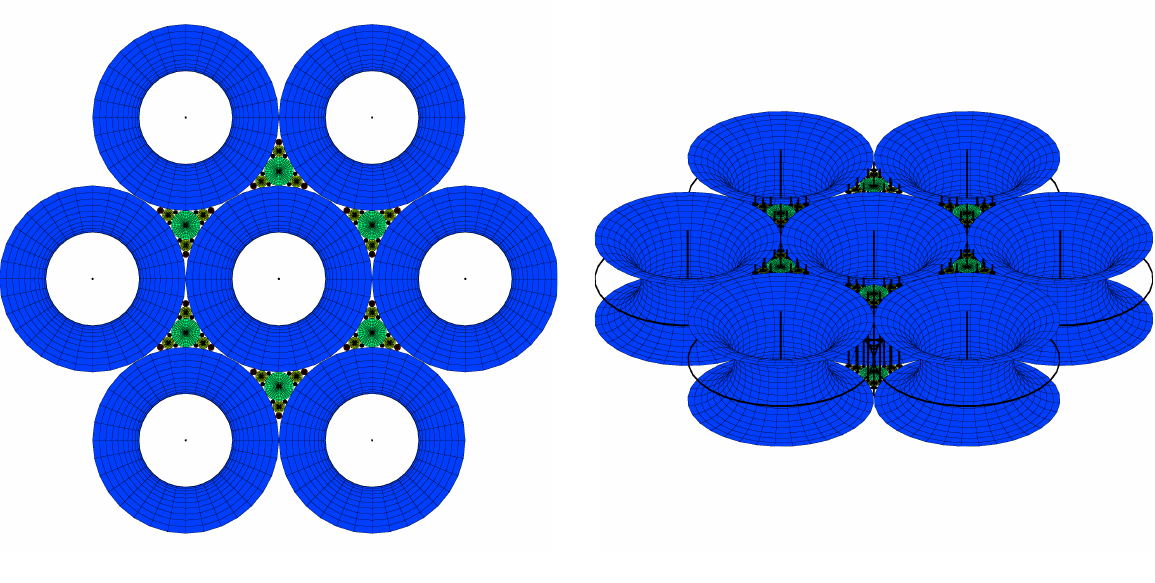
Figure 9. Dupin cyclides simulation: 1rst generation in blue, 2nd in green, 3rd in yellow, 4th in red. (a): Top view ( θ = 0 ◦ , ϕ = 90 ◦ ); (b) some side view ( θ = 60 ◦ , ϕ = 30 ◦